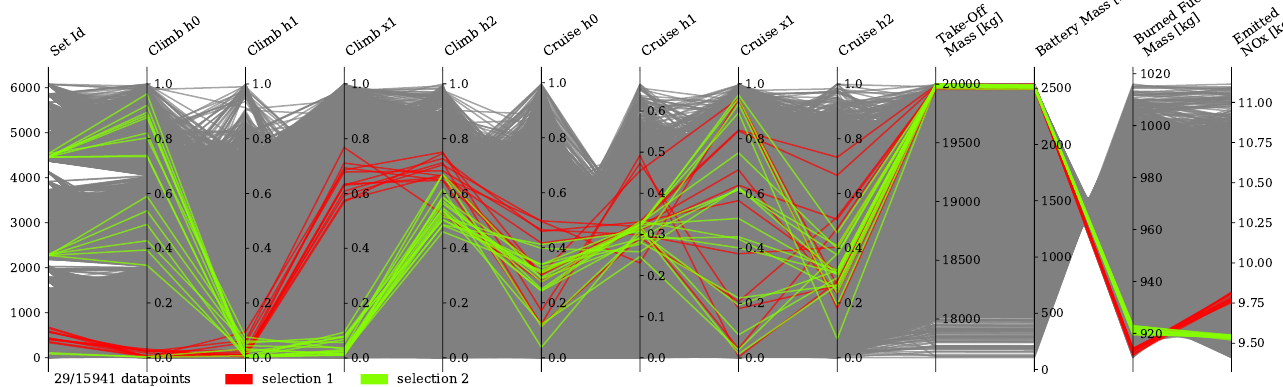
Figure 17. Parallel coordinates visualisation of Experiment 10.